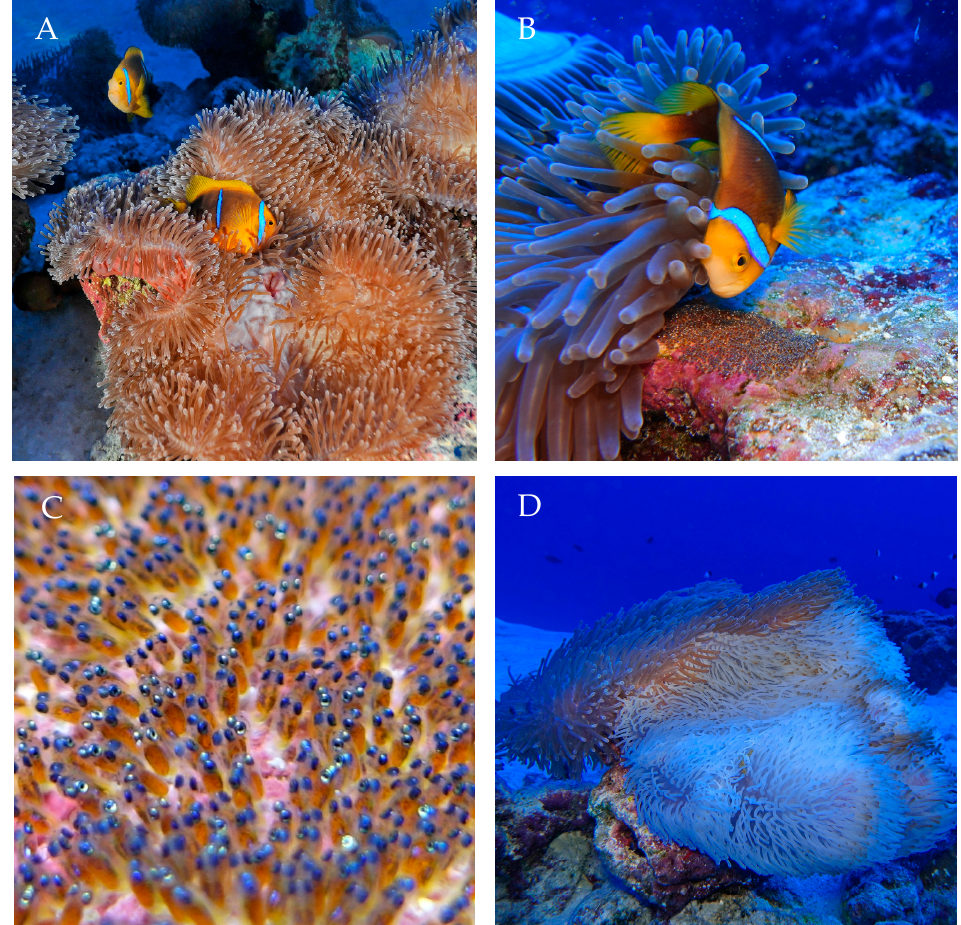
Figure 4. Orange-fin anemonefish, Amphiprion chrysopterus , and their host, the magnificent sea anemone Heteractis magnifica , in the mesophotic zone. ( A ) One of the three pairs living in Moorea at a depth of 48–50 m, ( B ) one adult living at a depth of 55 m in Tikehau, fanning its eggs, ( C ) 6-day old eggs spawned at 50 m in Moorea on 18 June 2020 and ( D ) a bleached anemone at 50 m in Moorea, August